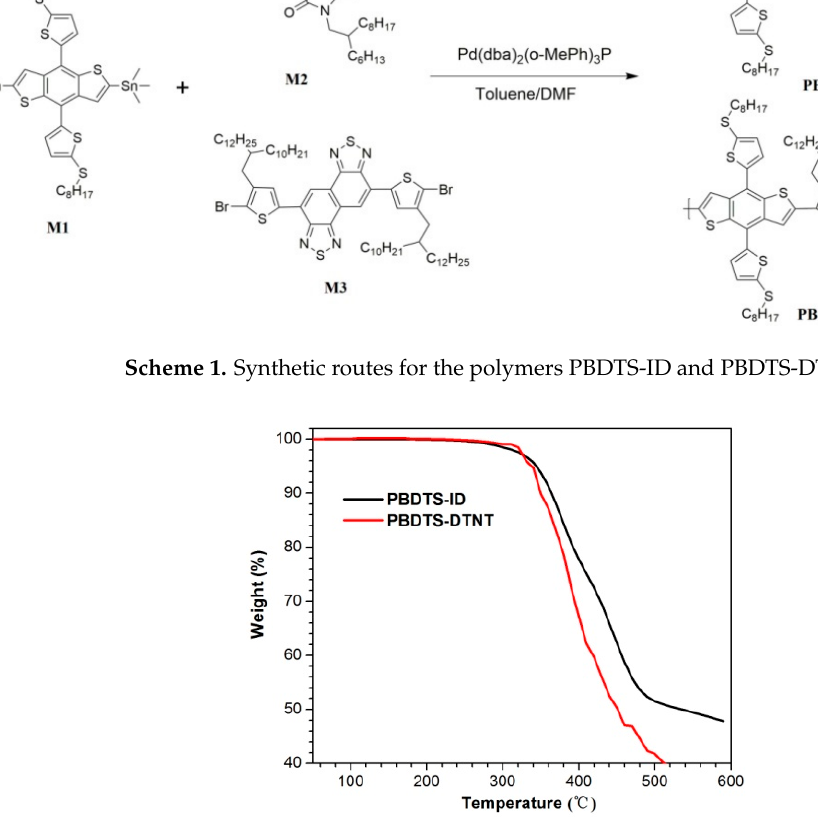
Figure 1. TGA curves of the polymers PBDTS-ID and PBDTS-DTNT.